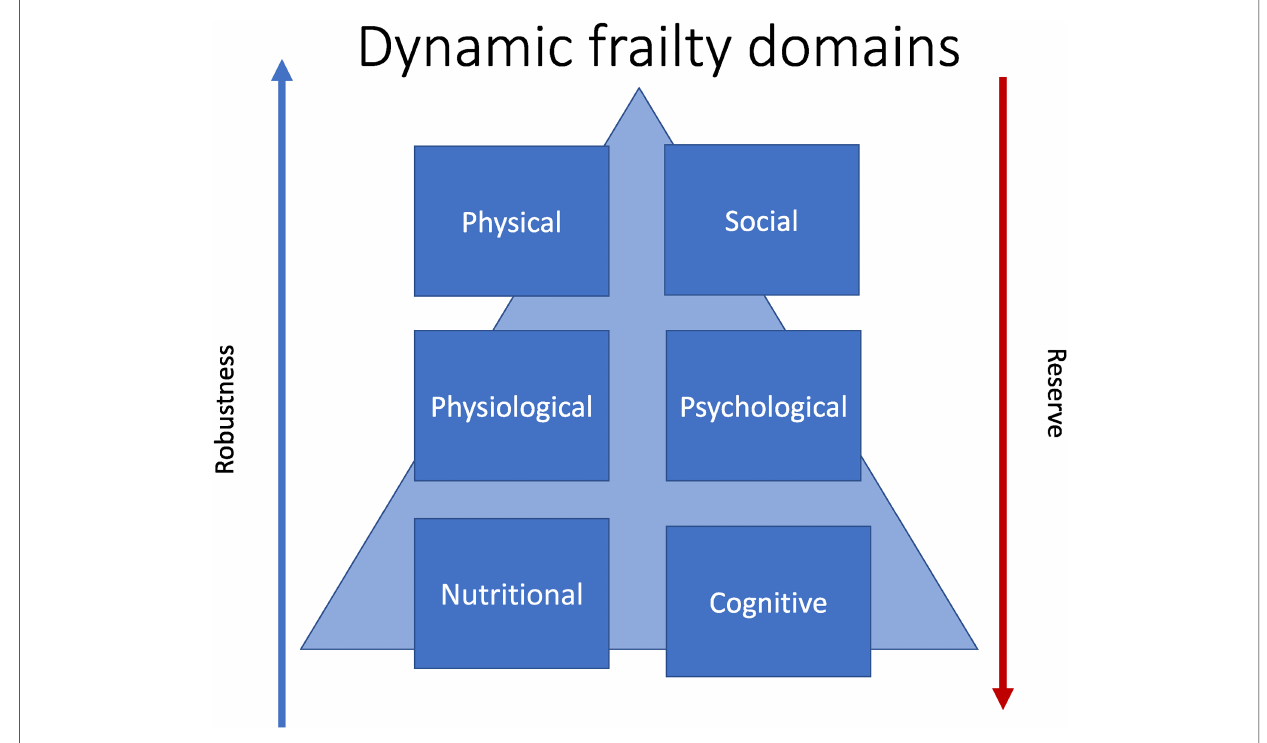
FIGURE 1 Dynamic frailty